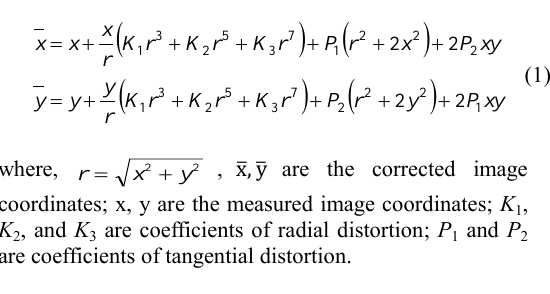
Figure 4. Results of camera